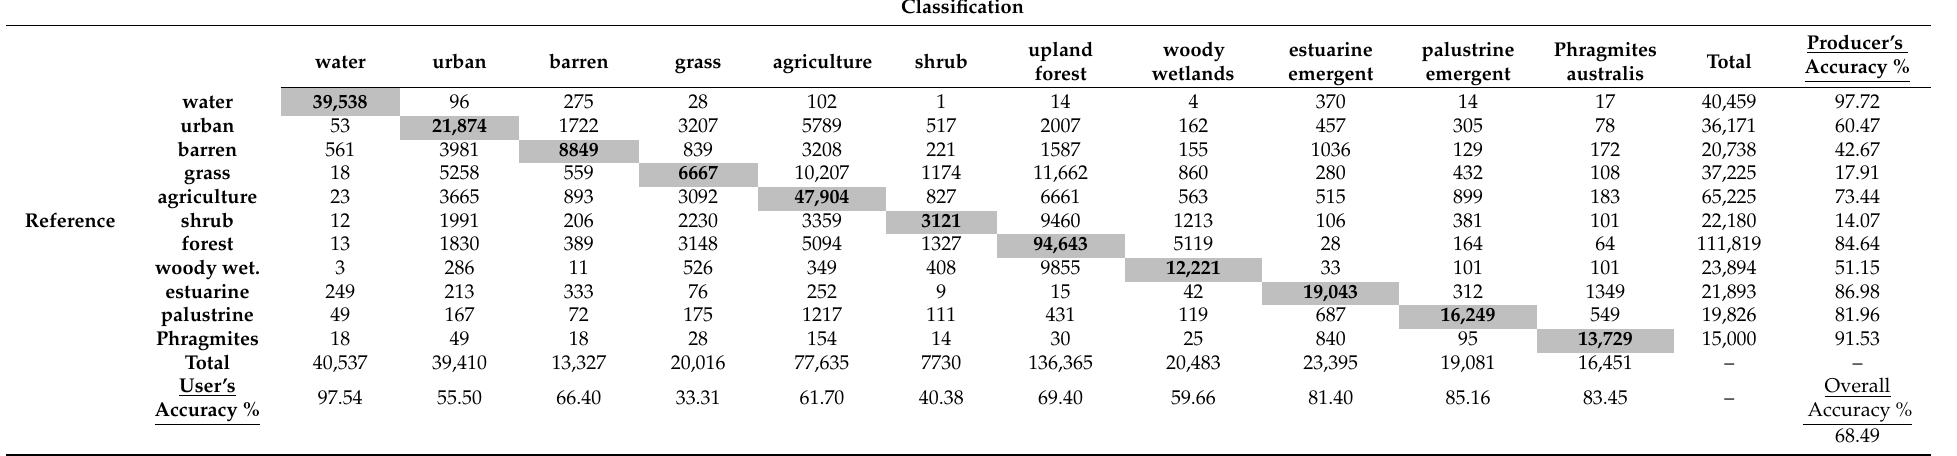
Table 2. Mid-Atlantic level-1 random forest classification confusion matrix.